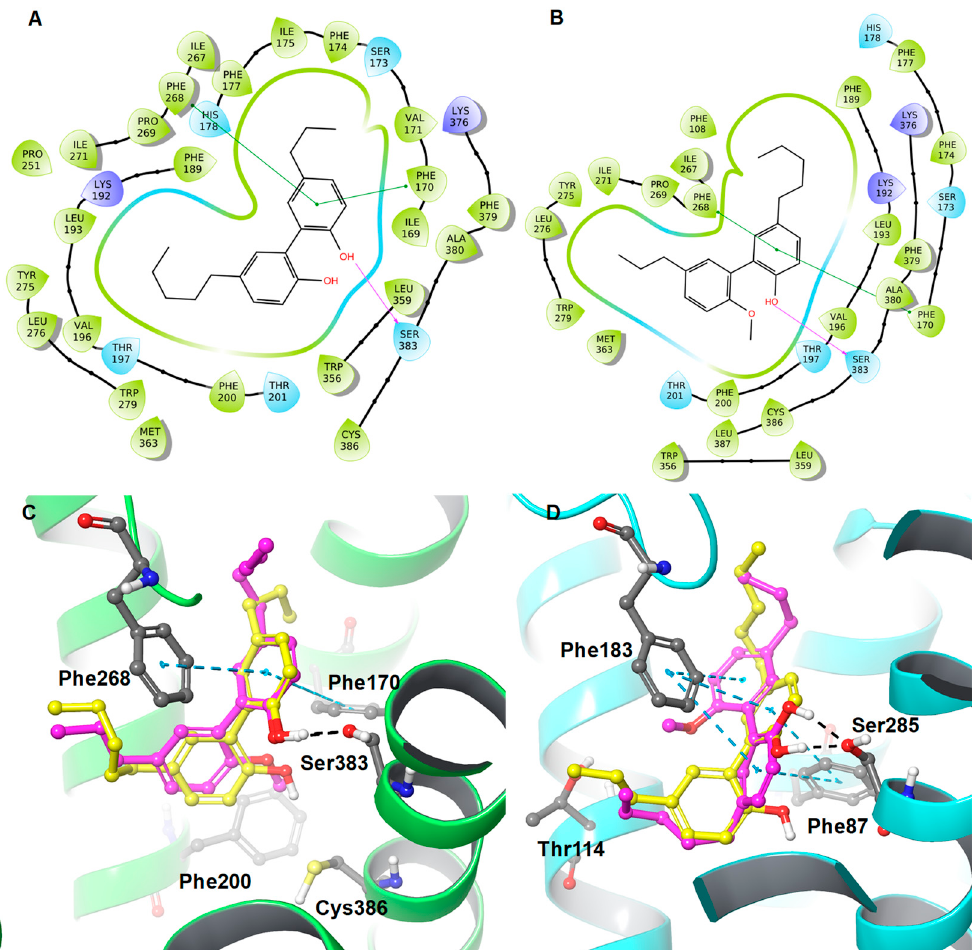
Figure 6. 2D interaction diagrams of ( A ) 5 and ( B ) 5a along with the 3D overlaid representations of ( C ) 5 (carbon in yellow) with 5a (carbon in magenta) against the CB1R and ( D ) 5 (carbon in yellow) with 5a (carbon in magenta) against the CB2R. The key residues are shown in the ball and stick model (carbon in grey).